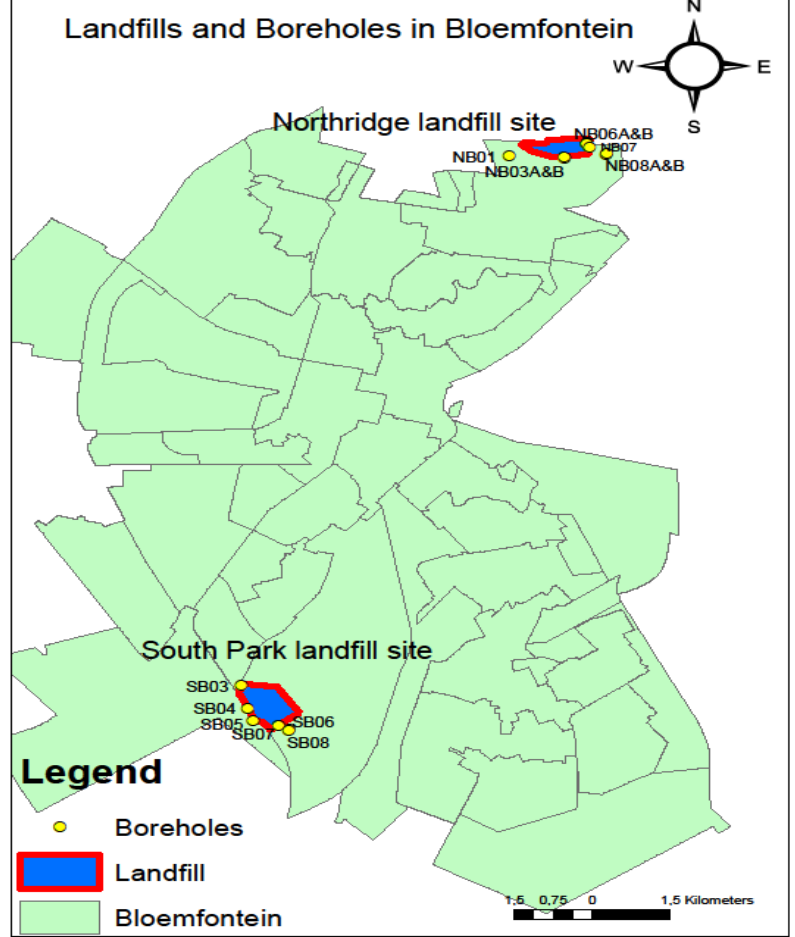
Figure 1. Map illustrating the two landfill sites in Bloemfontein and the location of the pollution monitoring boreholes in the vicinity of the two landfill sites . monitoring boreholes in the vicinity of the two landfill